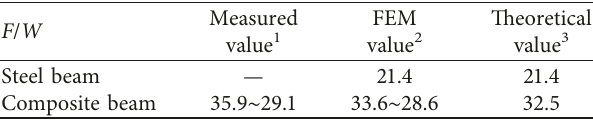
Table 2: Comparison of equivalent bending stiffness F / W (unit: